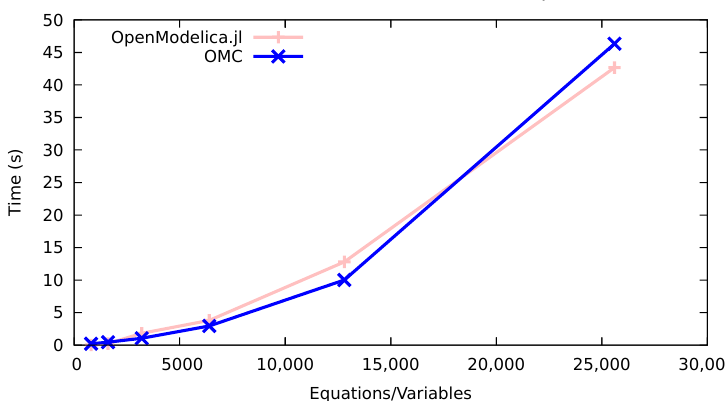
Figure 10. Time spent during numerical simulation for OpenModelica.jl (pink) and for OMC (blue). Lower is better.